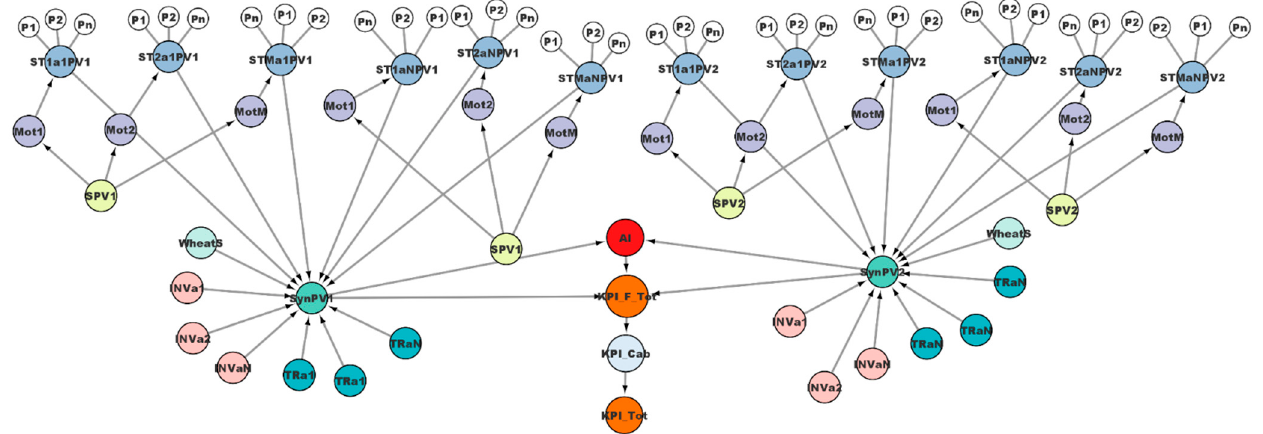
Figure A5. Complex architecture controlling two PV fields and related high-voltage network. The graph with linked nodes has been designed by Cytoscope . The KPIs of the analyzed system are listed in Table A2. All the variables are indicated in the graph of Figure A5. Table A2. KPI related to each level of PV complex system to control (BV is a basic value , BK is a basic KPI , CK is a complex KPI as a function of BV and BK). KPI KPI as dashboard monitoring M number of PV strings related to N subfields and for n PV fields (monitoring Pi variables and solar tracker efficiency). KPI as dashboard monitoring each PV field. Total indicator of the n PV fields.